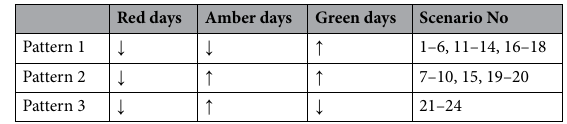
Table 4. Three patterns of